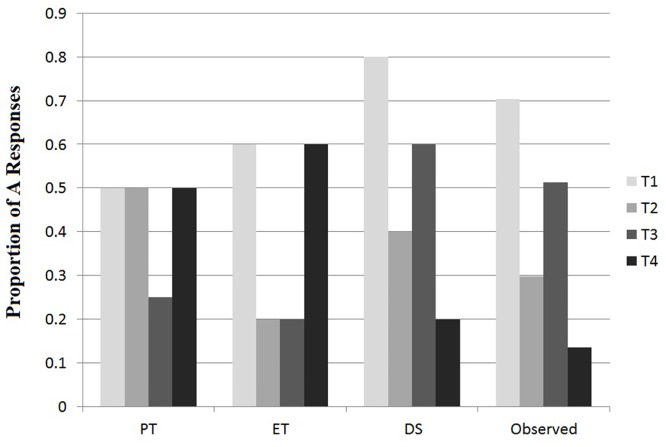
Observed data and prediction of PT, ET, and DS for likelihood of classifying the item as category “A” for each of the four transfer items.See Table 1 and Fig 1 for a description of each transfer item.